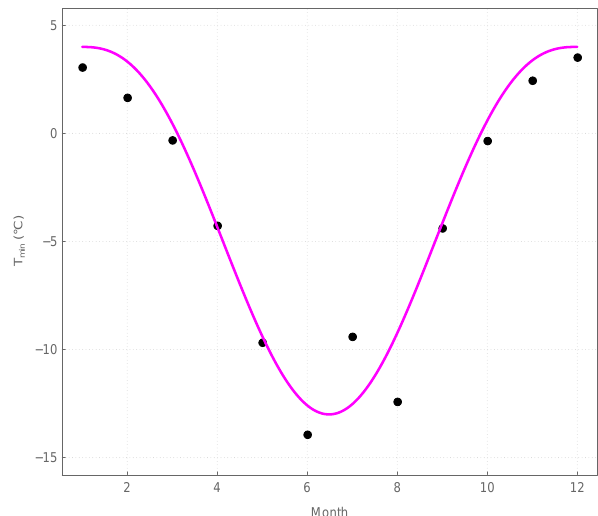
Figure 4. Seasonal value of T min estimated from a linear fit to the diagnostic values of a in the range of 0 < a < a max (black points) and compared to the parameterization given by Eq. (7) (magenta line).